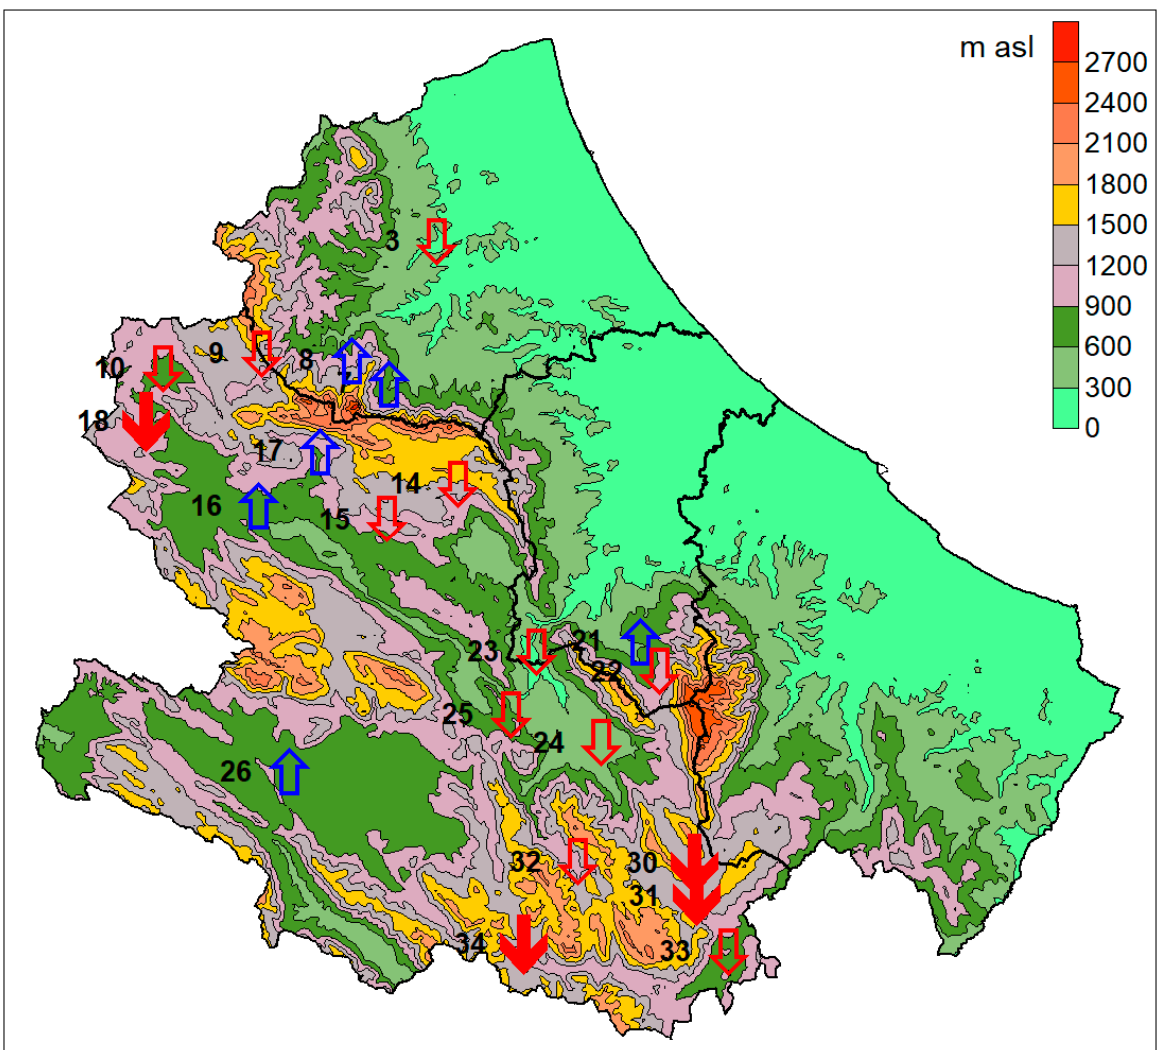
Figure 3. Map of the Abruzzo Region, indicating the increasing or decreasing trends of the number of days with minimum temperatures below − 10 °C. The downward arrows indicate decreasing trends, while the upward arrows indicate increasing trends. Full arrows indicate significant trends with p < 0.05, while empty arrows indicate no significance. The number next to the arrow indicates the numeric code of the meteorological station. The red arrows represent a warming trend, while the blue arrows represent a cooling trend. The altitude classes are given on the upper right.